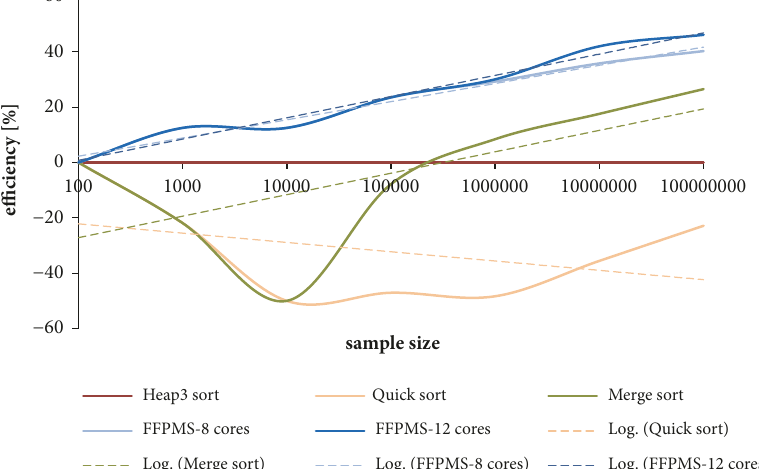
Figure 16: Benchmark comparison of the proposed Fully Flexible Parallel Merge Sort on 8 (light blue) and 12 (blue) cores to other sorting algorithms: heap sort with 3 divisions (brown), quick sort (cream), and classic merge sort (green) presented with logarithmic trend lines (dashed).